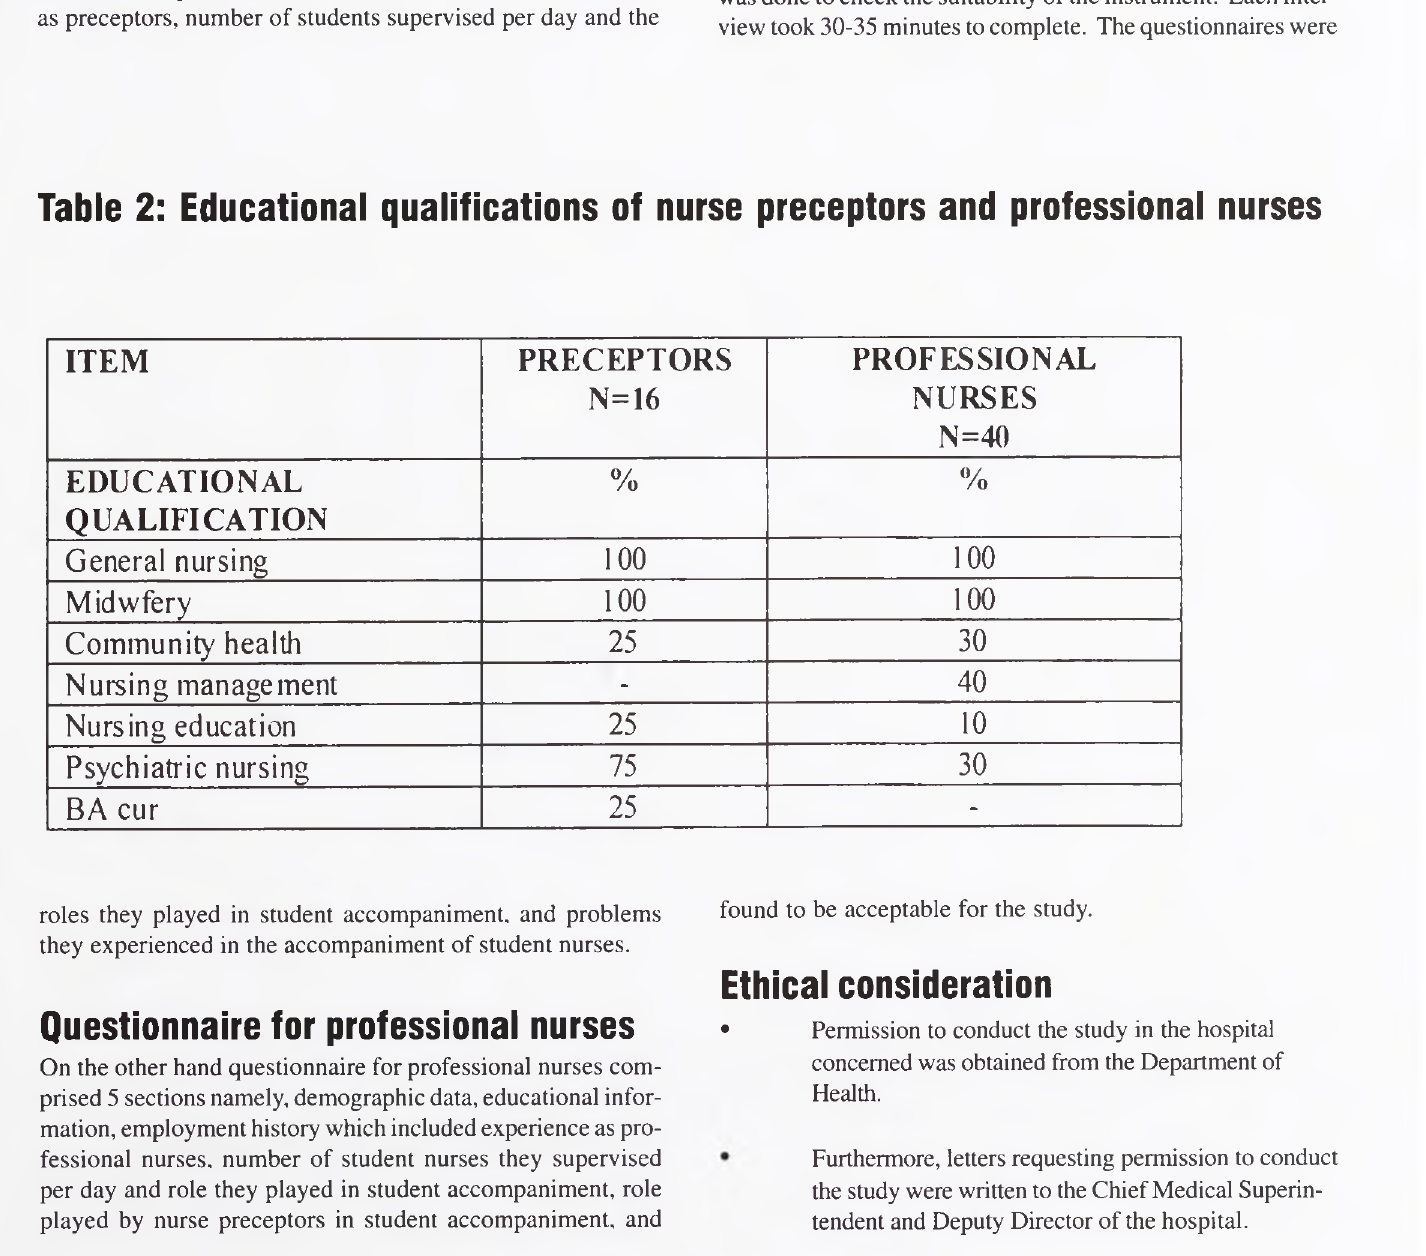
Table 2: Educational qualifications of nurse preceptors and professional nurses